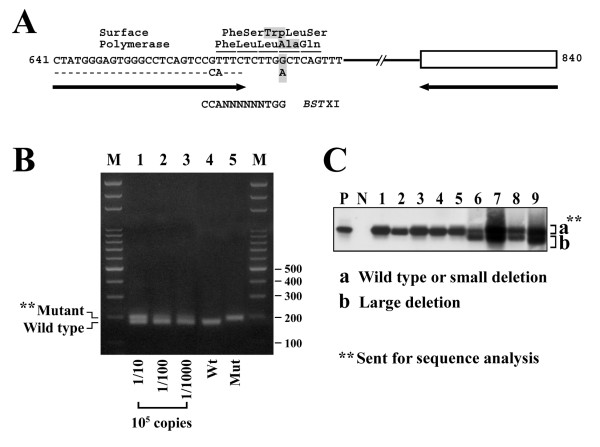
Methods to detect rtA181T mutations and pre-S internal deletion mutations. (A) Rationale of the amplification created restriction enzyme method to assist the detection of a small percentage of the rtA181T mutant. Partial amino acid sequences of the surface and polymerase genes were shown. Arrow (left), a mismatched primer with two nucleotides (CA) mismatches; Arrow (right), a matched antisense primer. A BST XI site was created if the amplicon was wild type. (B) Digestion of the PCR products with BST XI separated the wild type amplicon from the mixture. The undigested (mutant) DNA was gel-purified and submitted for sequence verification. In a 105 copies of mixture, this method could detect 1/1000 (102 copies) of mutant. (C) Detection of the pre-S internal deletion mutants. The PCR product was analyzed by Southern blot to detect large deletion (b). The pre-S sequence with or without small deletions (a) was gel-purified and sent for sequence analysis.